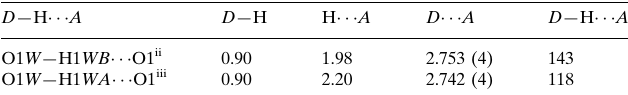
Hydrogen-bond geometry (A˚ , (cid:1)